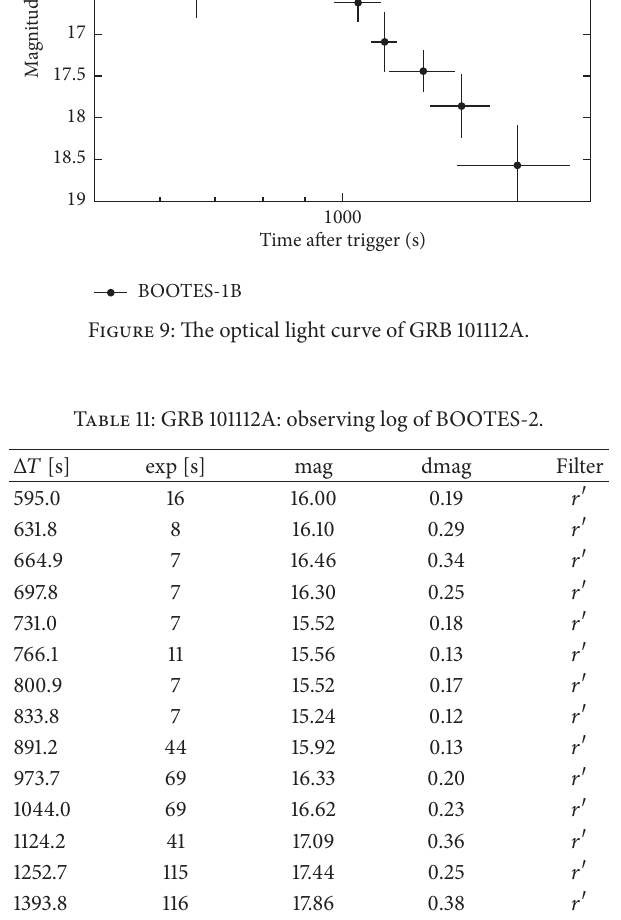
detected also the following night with 𝑅 = 19.35 ; see Table 10 and Figure 8.